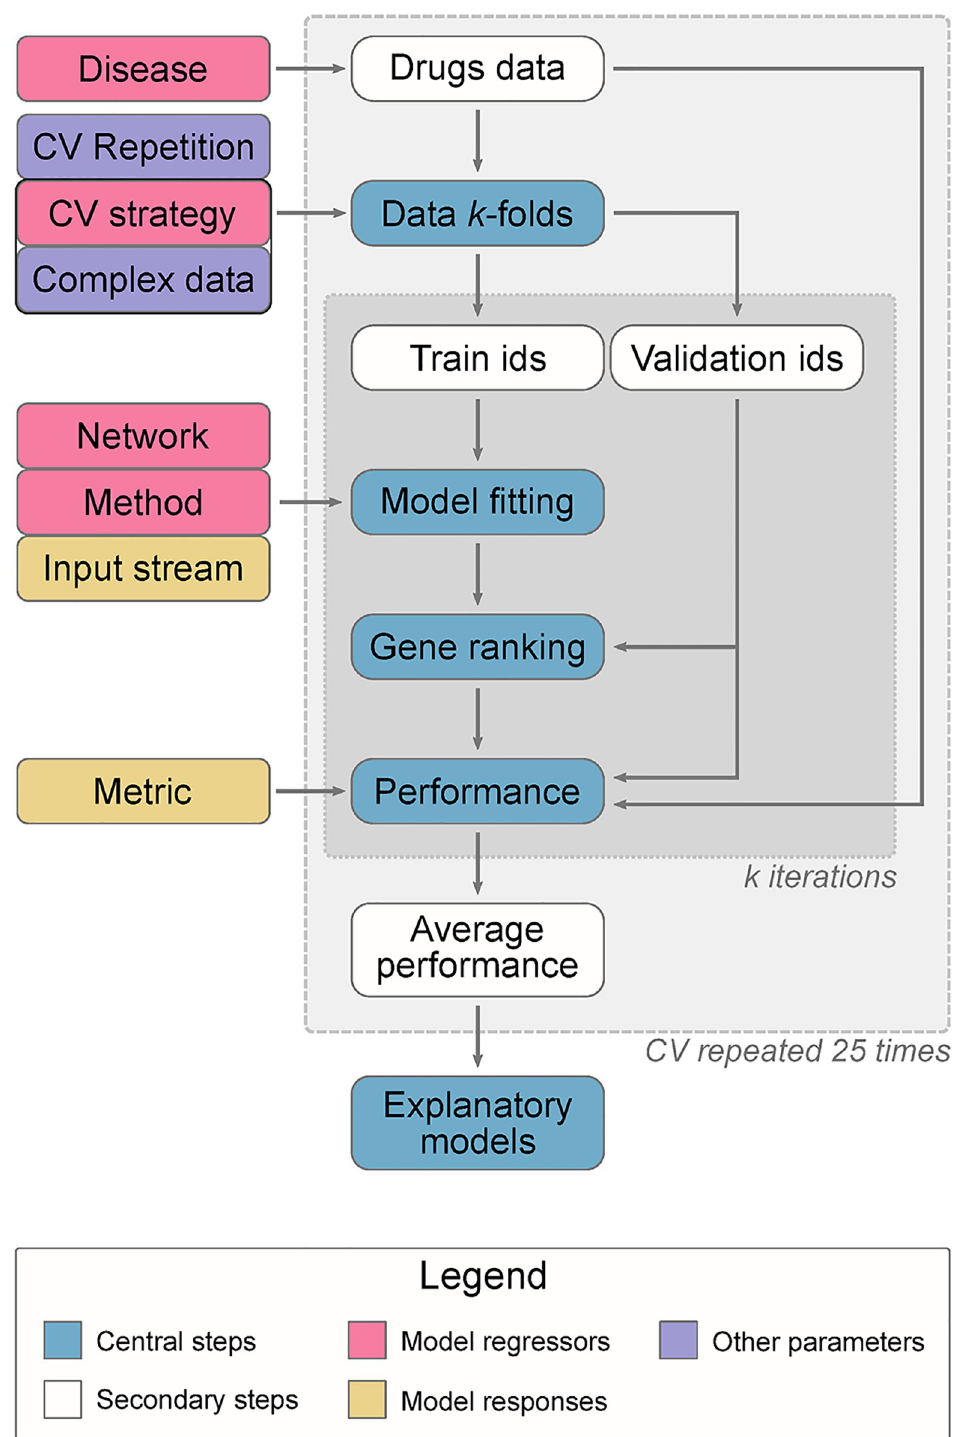
Fig 1. Benchmark overview. This work describes six performance metrics using two input streams (genetic association and drug-based genes) to predict drug target-based genes for 22 common diseases. 3-fold cross-validation (CV), repeated 25 times, was run under three CV strategies. The gene identifiers in each fold are determined using only the drugs data, regardless of the input. Two validation strategies are complex-aware and therefore needed this data to define the splits. 15 methods based on network propagation (including 4 baselines) were evaluated, using two networks